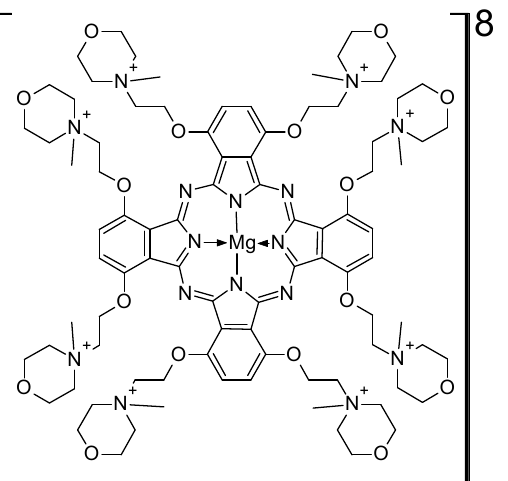
Figure 1. The chemical structure of magnesium(II) phthalocyanine with peripheral 2-(4-N- methylmorpholin-4-ium-4-yl)ethoxy substituents.